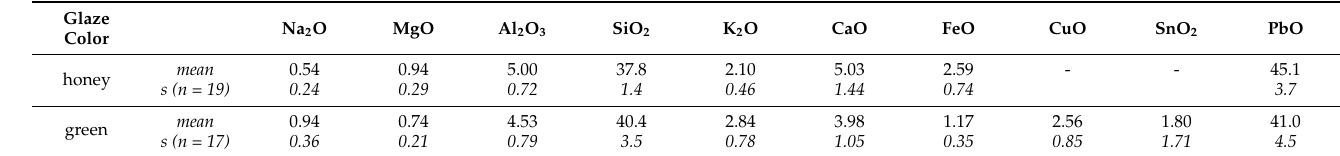
Table 4. Chemical composition (%wt) of monochrome glazes by